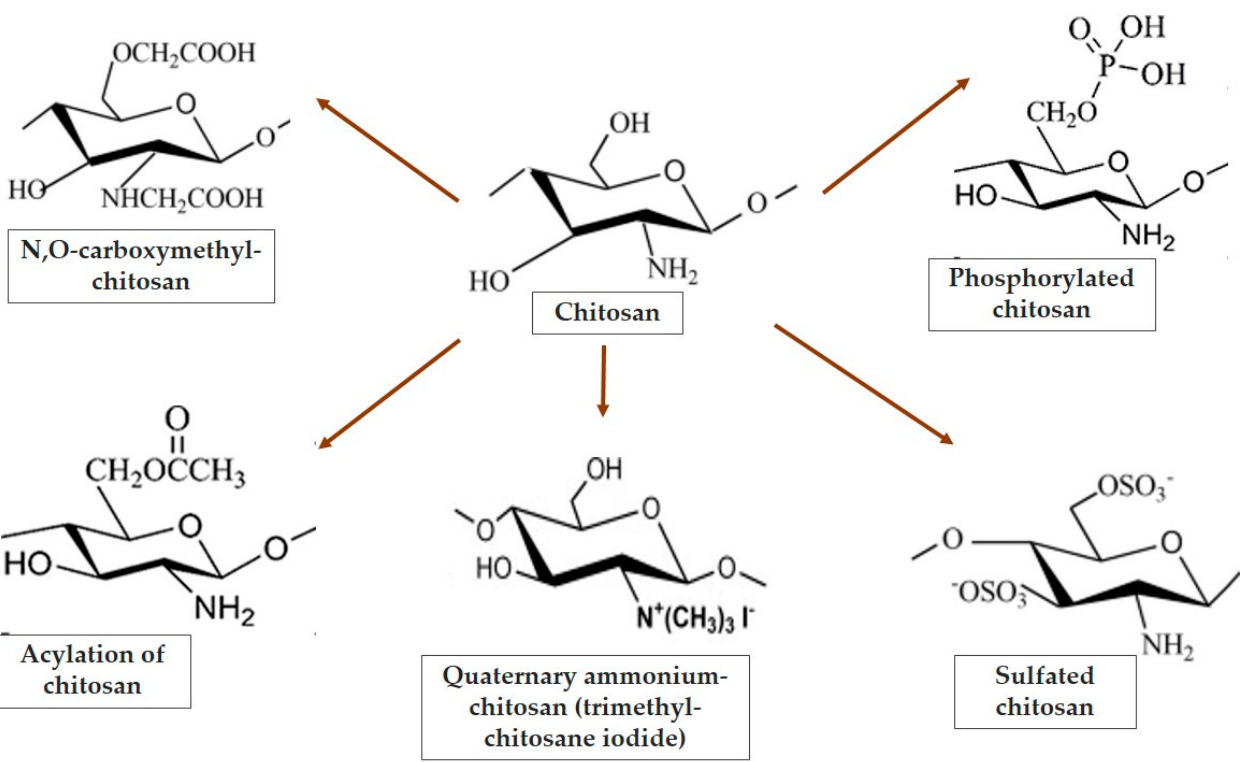
Figure 2. Examples of chitosan functionalization.